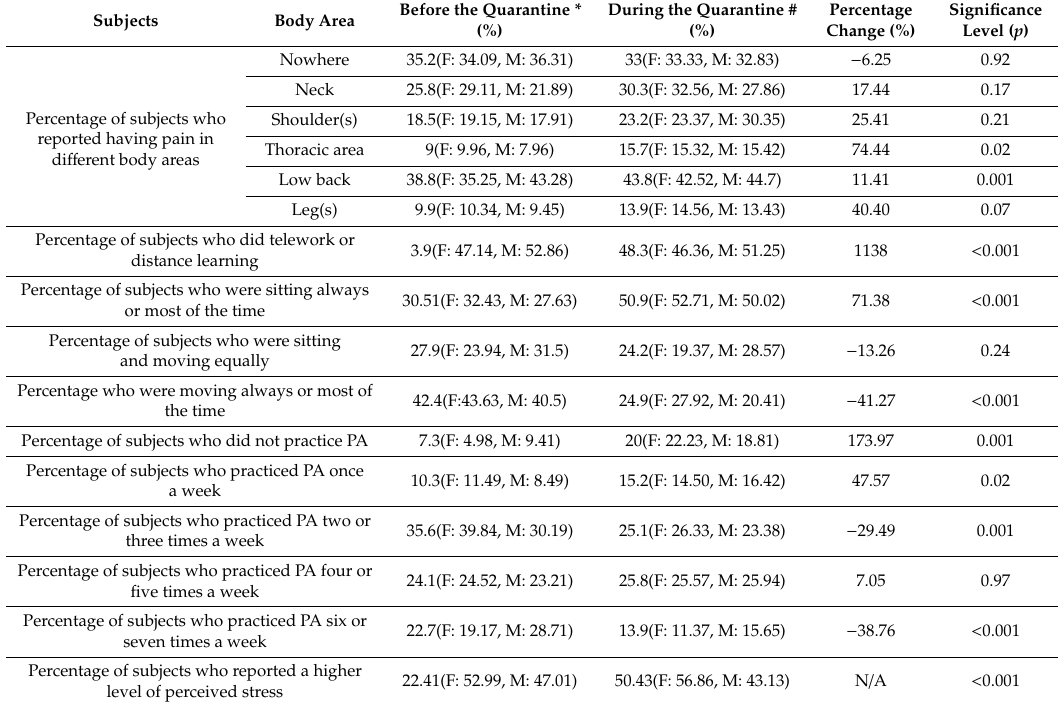
Table 1. Changes experienced by citizens due to the